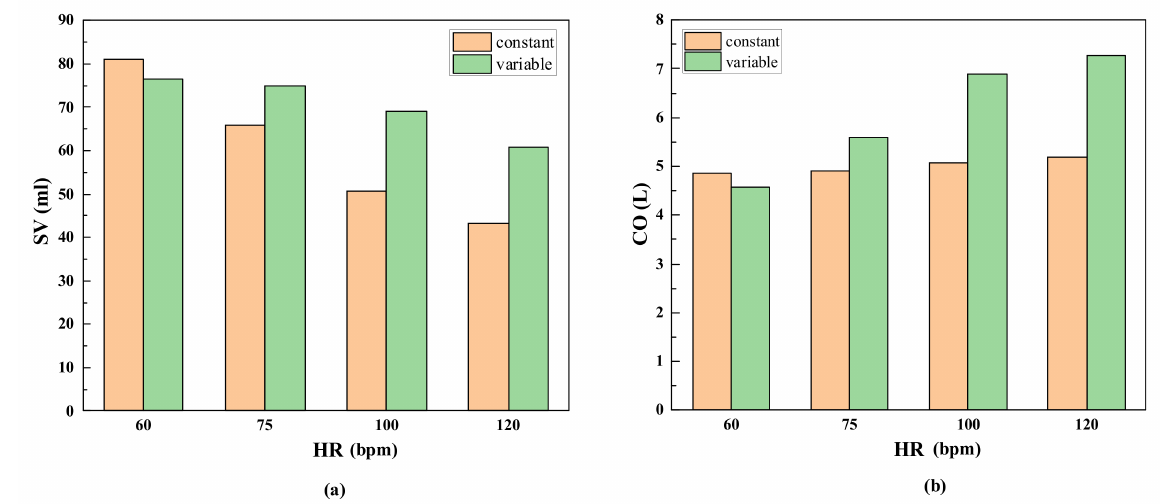
Figure 8. Comparison of flow output under two control strategies. ( a ) the stroke volume at different heart rates, ( b ) the cardiac output after pump assistance.